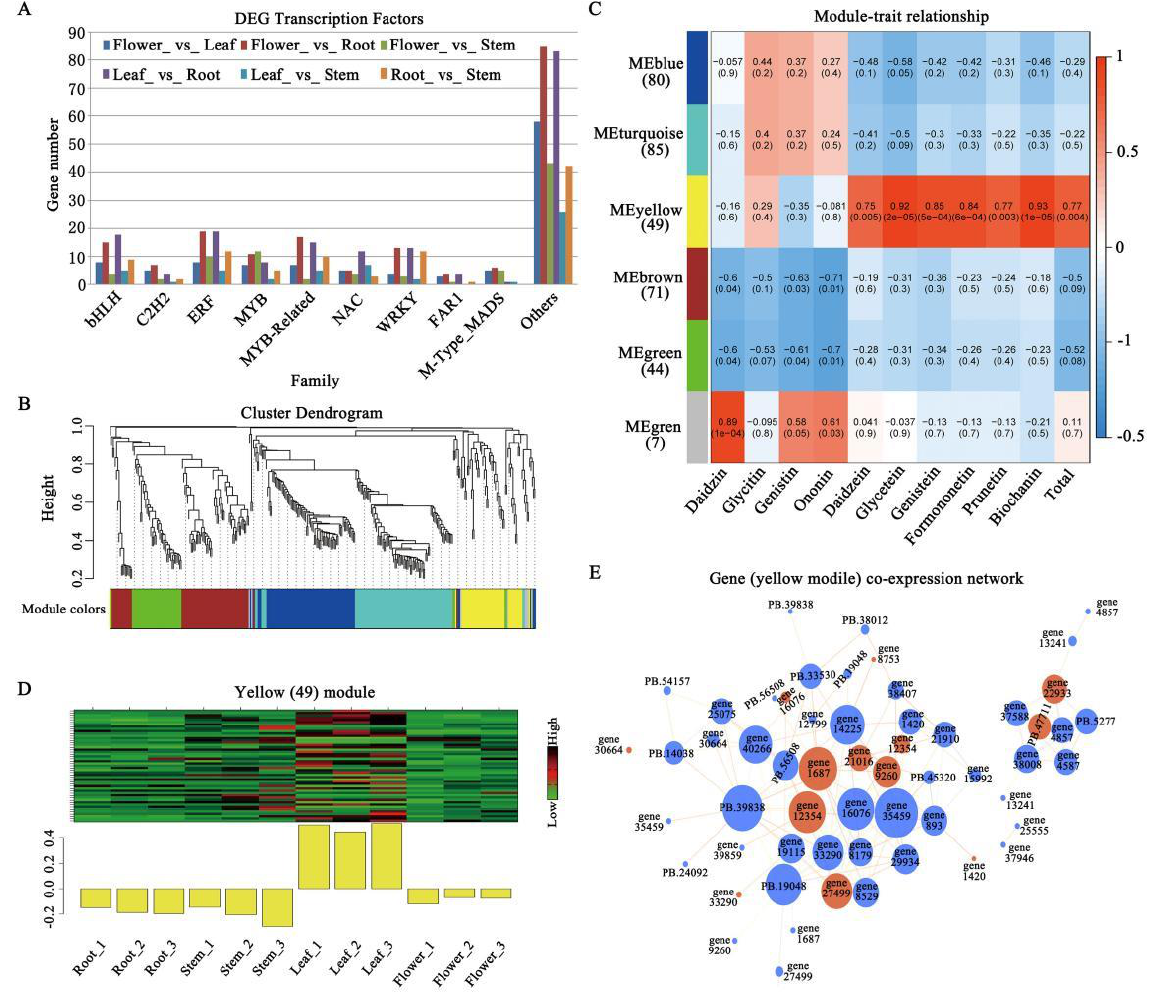
Figure 5. The WGCNA of differentially expressed transcription factors in four tissues (root, stem, leaf, and flower). ( A ) Differentially expressed TF families of genes. ( B ) The cluster dendrogram of differentially expressed transcription factors. Each branch in the figure represents one gene, and every color below represents one co-expression module. ( C ) Heatmap of the correlation between module and the content of isoflavonoids. The color of each cell at the row– column intersection indicates the correlation coefficient between the module and isoflavonoid content. The color scale indicates the magnitude of the correlation coefficient, ranging from low (blue) to high (red). ( D ) Heatmap and expression pattern of the genes in different tissues in the yellow module. ( E ) Visualization of connections of genes in the yellow module. Each node represents a gene and the connecting lines (edges) between genes represent co-expression correlations (Supplementary Table S9). Forty-three TFs with edge weights ≥ 0.2 are visualized using Cytoscape. Thirty-two TFs are shown by larger circles. Twelve hub genes belonging to the bHLH, MYB, and MYB-related TF families are shown in